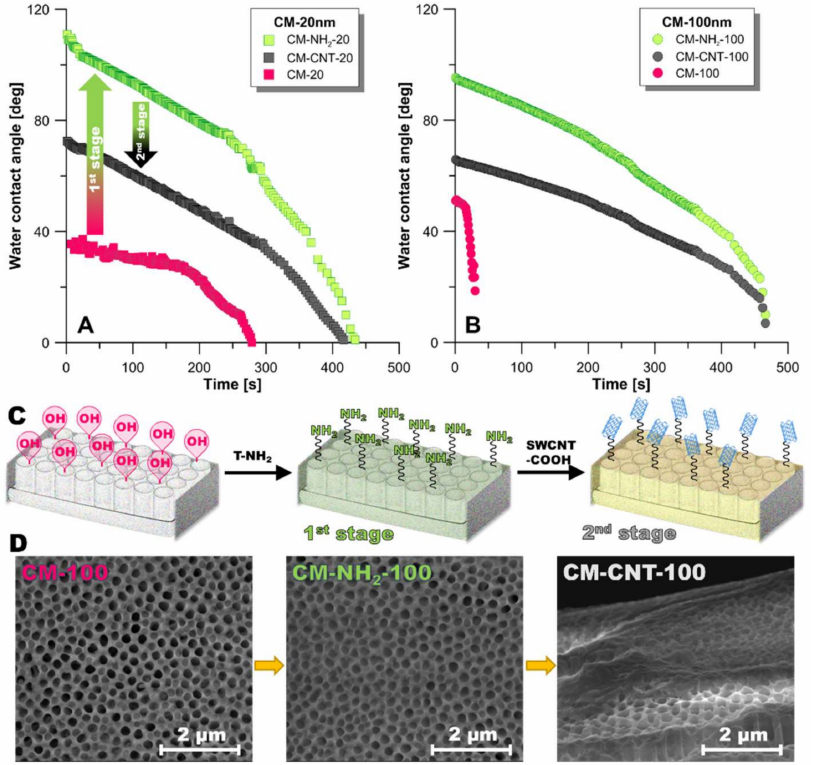
Figure 6. Dynamic contact angle (CA) measurements for modified samples of CM-20 ( A ) and CM-100 ( B ); ( C ) SEM images of the membrane after first (with 3-aminopropyl)triethoxysilane—T-NH 2 ) and second step (with carbon nanotubes—CNTs) of